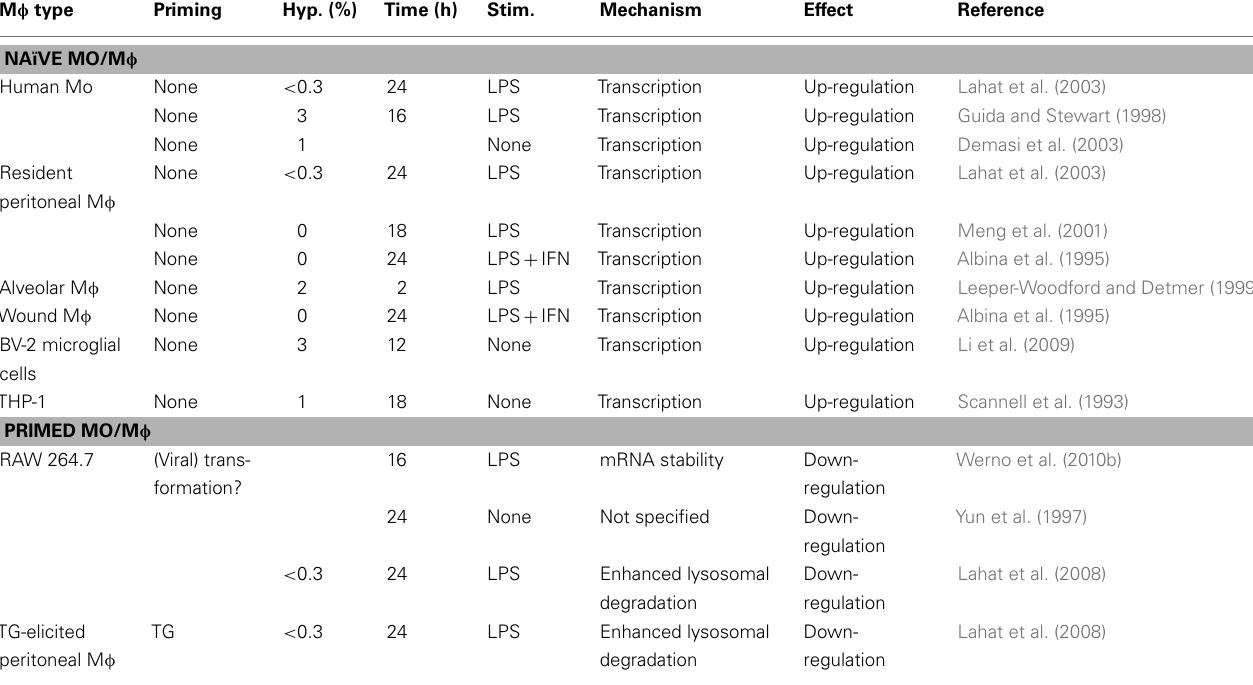
Table 2 | Controversial effects of hypoxia onTNF α secretion from M φ